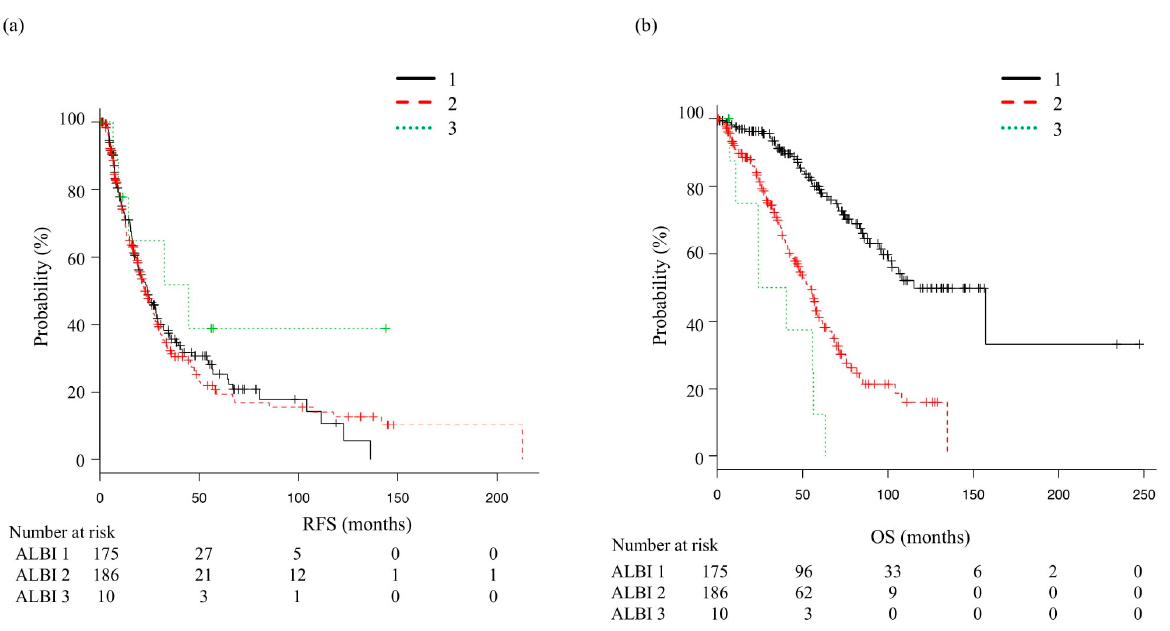
Figure 3. Recurrence-free survival (RFS) and overall survival (OS) according to albumin–bilirubin (ALBI) grade. ( a ) Median recurrence-free survival (mRFS) was 24 months (95% CI: 19.1–28.5) for ALBI grade 1, 22.5 months (95% CI: 19.3–27.6) for ALBI grade 2, and 44.6 months (95% CI 6.7—not applicable) for ALBI grade 3 ( p = 0.476). ( b ) Median OS was 115.3 months (95% CI: 96.0—not applicable) for ALBI grade 1, 54.8 months (95% CI: 45.0–58.9) for ALBI grade 2, and 32.2 months (95% CI, 7.2–56.3) for ALBI grade 3 ( p < 0.01).